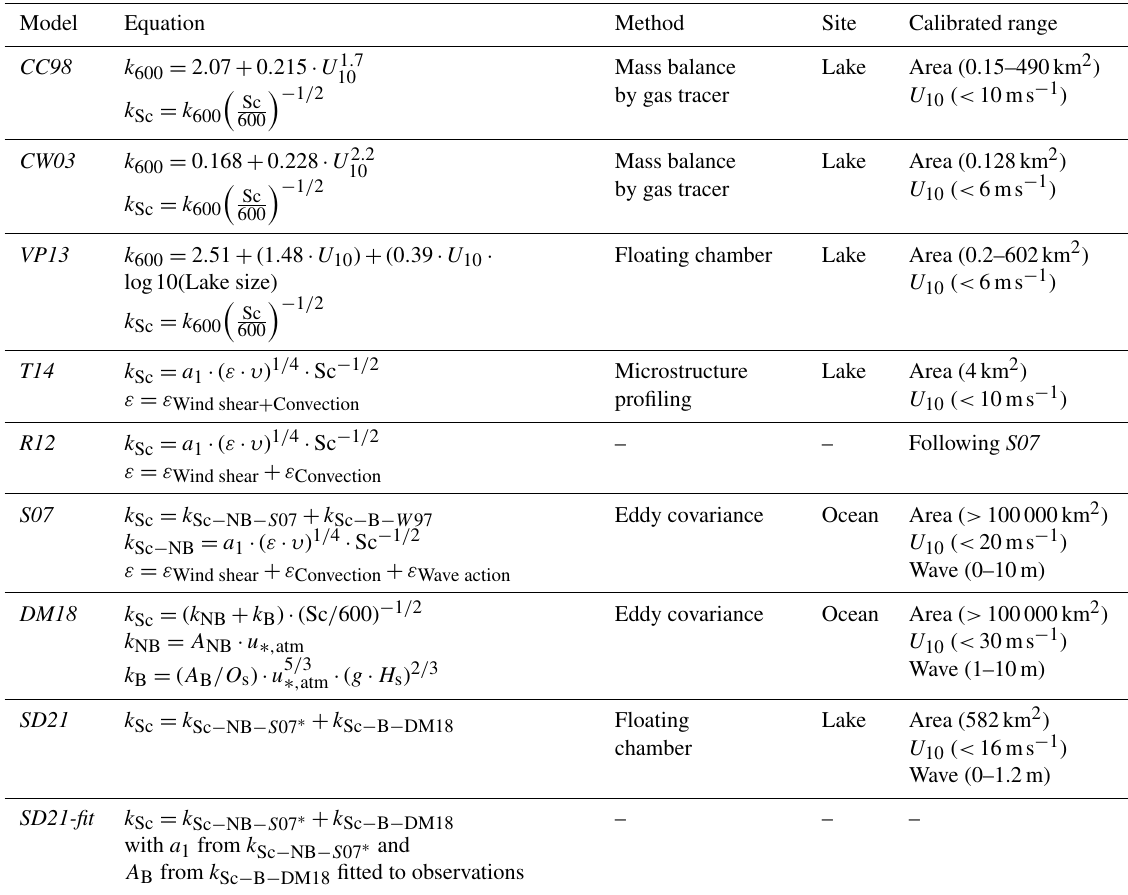
Table 1. Summary of the characteristics of k Sc models for predicting the air–water gas transfer velocity based on wind speed ( CC98 and CW03 ) and lake size ( VP13 ), surface renewal model ( T14 , R12 , and S07 ), COARSE approach ( DM18 ), and both adapted models, namely SD21 and SD21-fit , from a combination of S07 and DM18